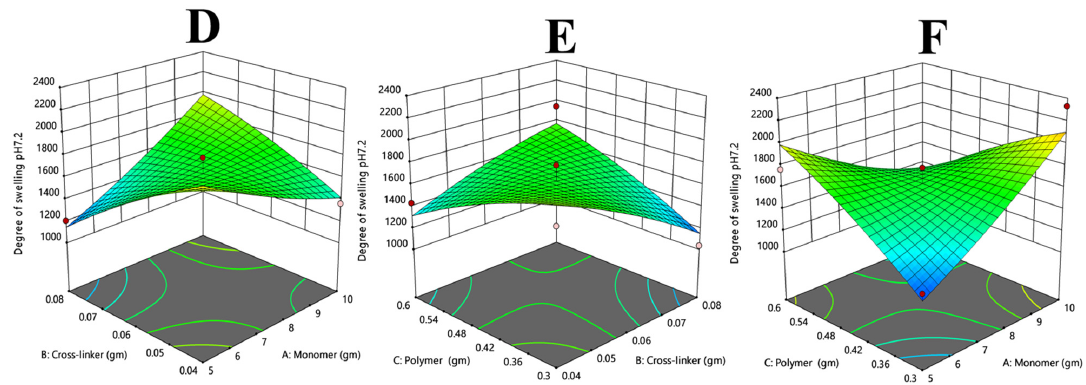
Figure 4. Illustrates the effects of varying concentrations of monomer and crosslinker ( A , D ), pol- ymer and crosslinker ( B , E ), and polymer and monomer ( C , F ) on the degree of swelling. It is clearly evident that both polymer and monomer had a positive effect on the swelling index of a hydrogel, whereas the crosslinker showed the opposite effect.